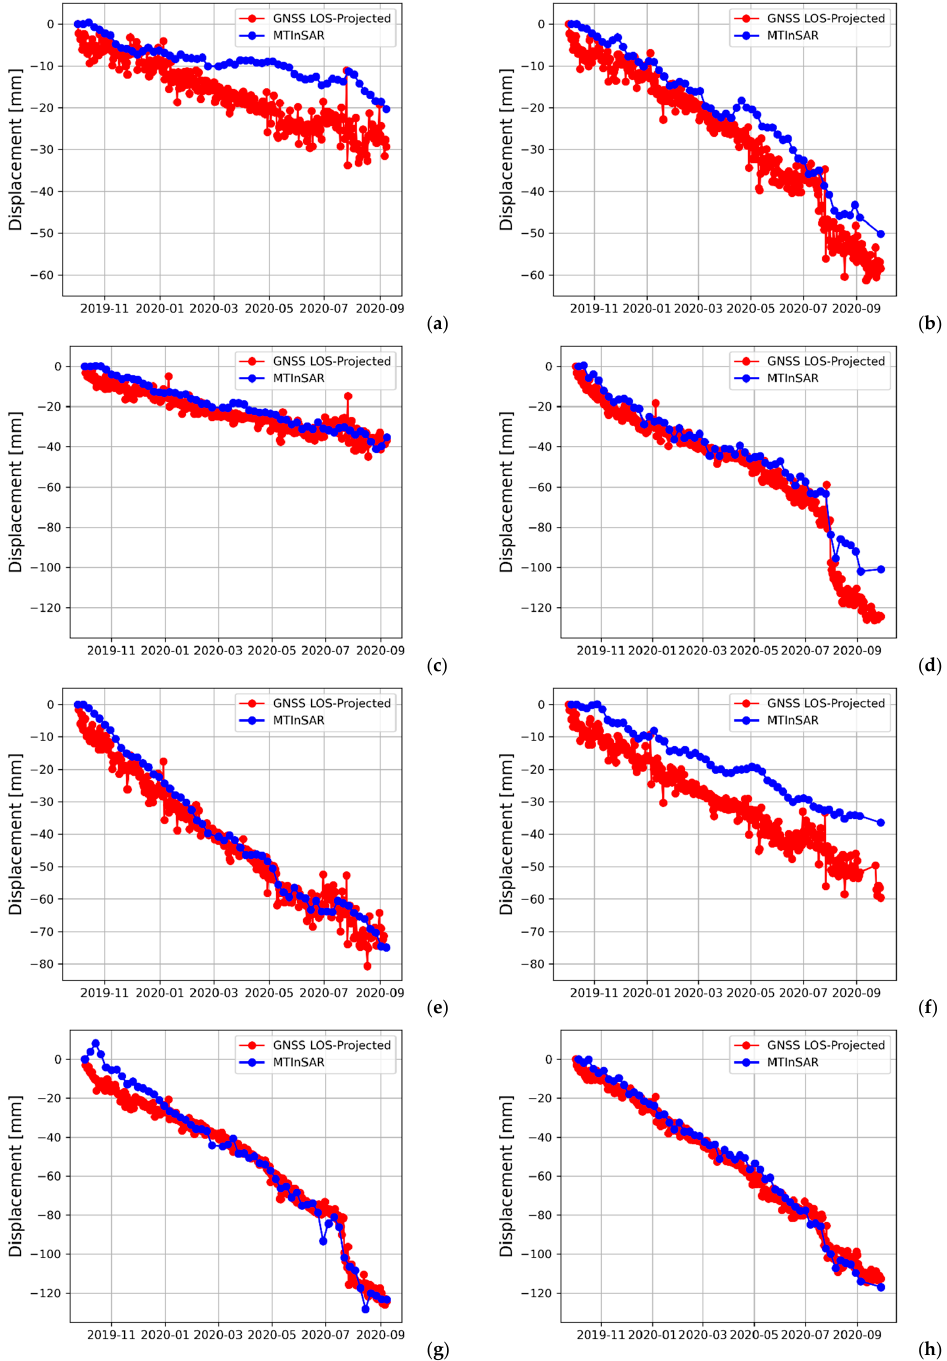
Figure 8. Displacement time series comparing MTInSAR (blue) and GNSS data projected onto the radar line of sight (red), for the points in the vicinity of the GNSS stations: ZHSR, asc ( a ) and desc ( b ); PIES, asc ( c ) and desc ( d ); ZHPR, asc ( e ) and desc ( f ); WYZY, asc ( g ) and desc ( h